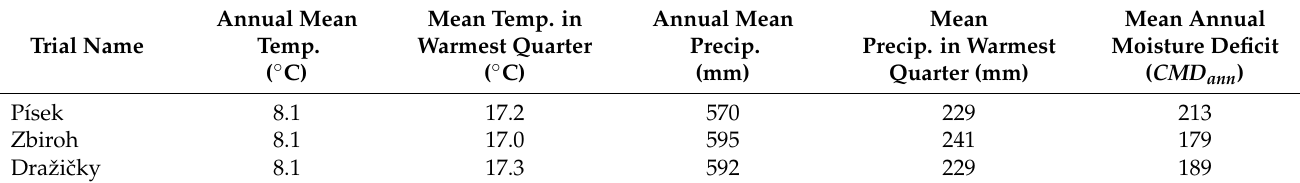
Table 2. Current climate parameters of the three provenance tests, calculated according to the described protocol.